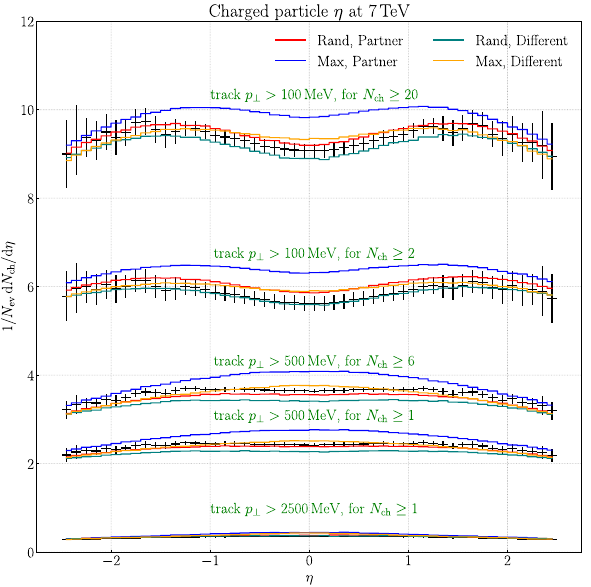
Fig. 10 Thecharged-particlemultiplicityisplottedagainsttherapidity for multiple cuts (green labels) on the hardest track transverse momen- tum and number of charged particles. Data is taken from [46]. This observable is sensitive to the choices that are employed as the starting conditions of the parton shower process. The four choices are described in Sec. 4.3. While height differences are easily modified in the tuning process, shape differences prefer choices with a random colour partner for gluons in the hard process